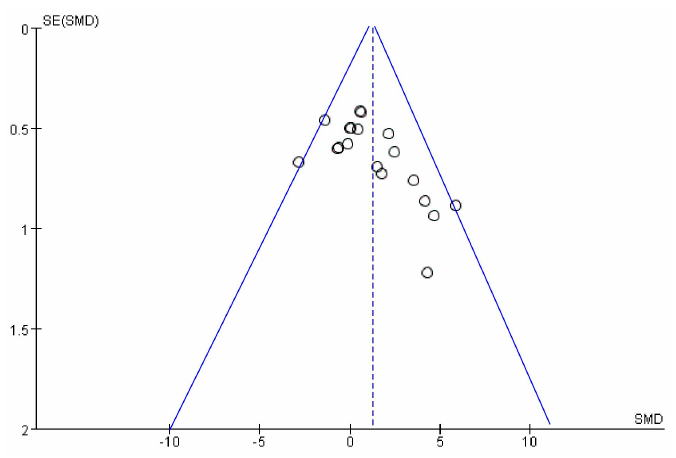
Figure 11. Comparison of DPPH radical scavenging activity between control and S. crispa groups. ( ): SMD of individual studies; (  ): summary SMDs of the comparison. 2.8. Sensitivity Analysis Studies that used the same S. crispa extract, similar dosages and the same experimental objects were included in the sensitivity analysis. Wound healing rates in diabetes treatment and survival of cancer cells after anti-tumor activity were analyzed (Figures 12 and 13). All cases showed a high homogeneity and a high reduction of the percentages of cancer cells (SMD = 16.08 (1.83, 27.32), I 2 = 0%), as well as an improved wound healing ability of the objects (SMD = 2.89 (1.87, 3.90), I 2 = 13%) after treatment with S. crispa .